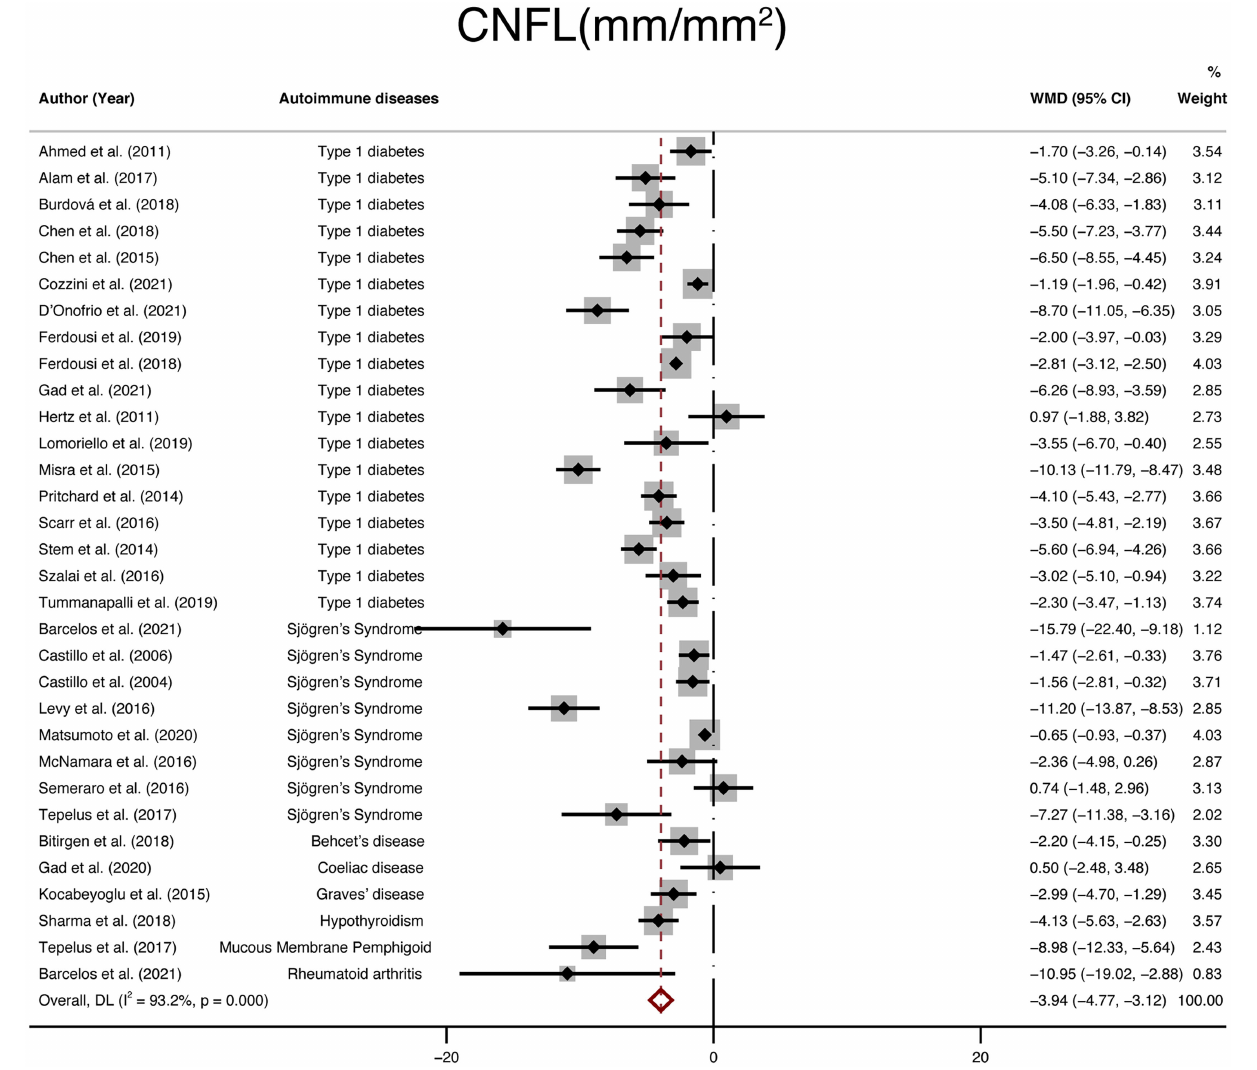
studies that reported CNBD, heterogeneity was significantly reduced for studies grouped by the software used only when using Image J to assess CNBD (I 2 0%). The detailed results of = subgroup analysis are depicted in Table 3